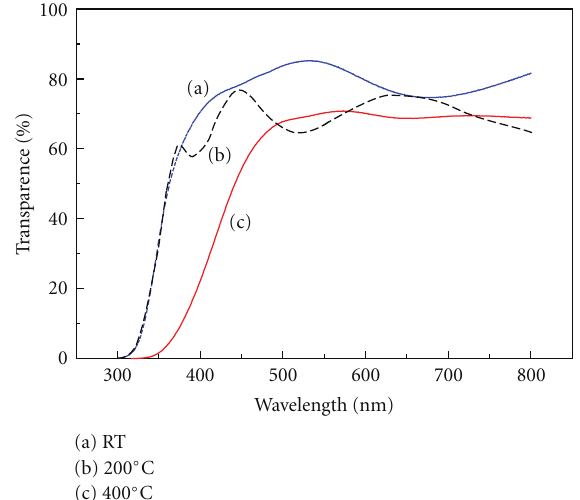
Figure 1: Transmission spectra of N-doped TiO 2 films prepared at di ff erent temperature, (a) RT, (b) 200 ◦ C, (c) 400 ◦